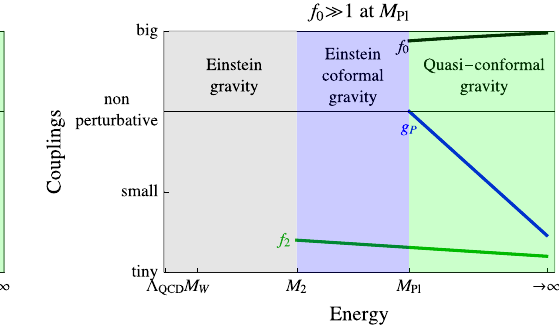
and f 0 (cid:15) 1 at the Planck scale (right). Here M Pl is the Planck mass, √ M 2 ≡ f 2 ¯ M Pl / 2 is the graviton ghost mass, (cid:16) 0 is the RGE scales at which f 0 ∼ 4 π